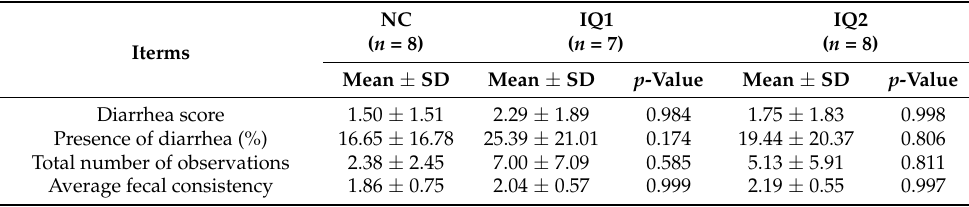
Table 7. Diarrhea scores over 10 observations during the lactation period of piglets born from sows that received either a basal diet (NC), or supplementation with isoquinoline alkaloids (IQ) during gestation and lactation (IQ1), or only during the lactation period (IQ2).